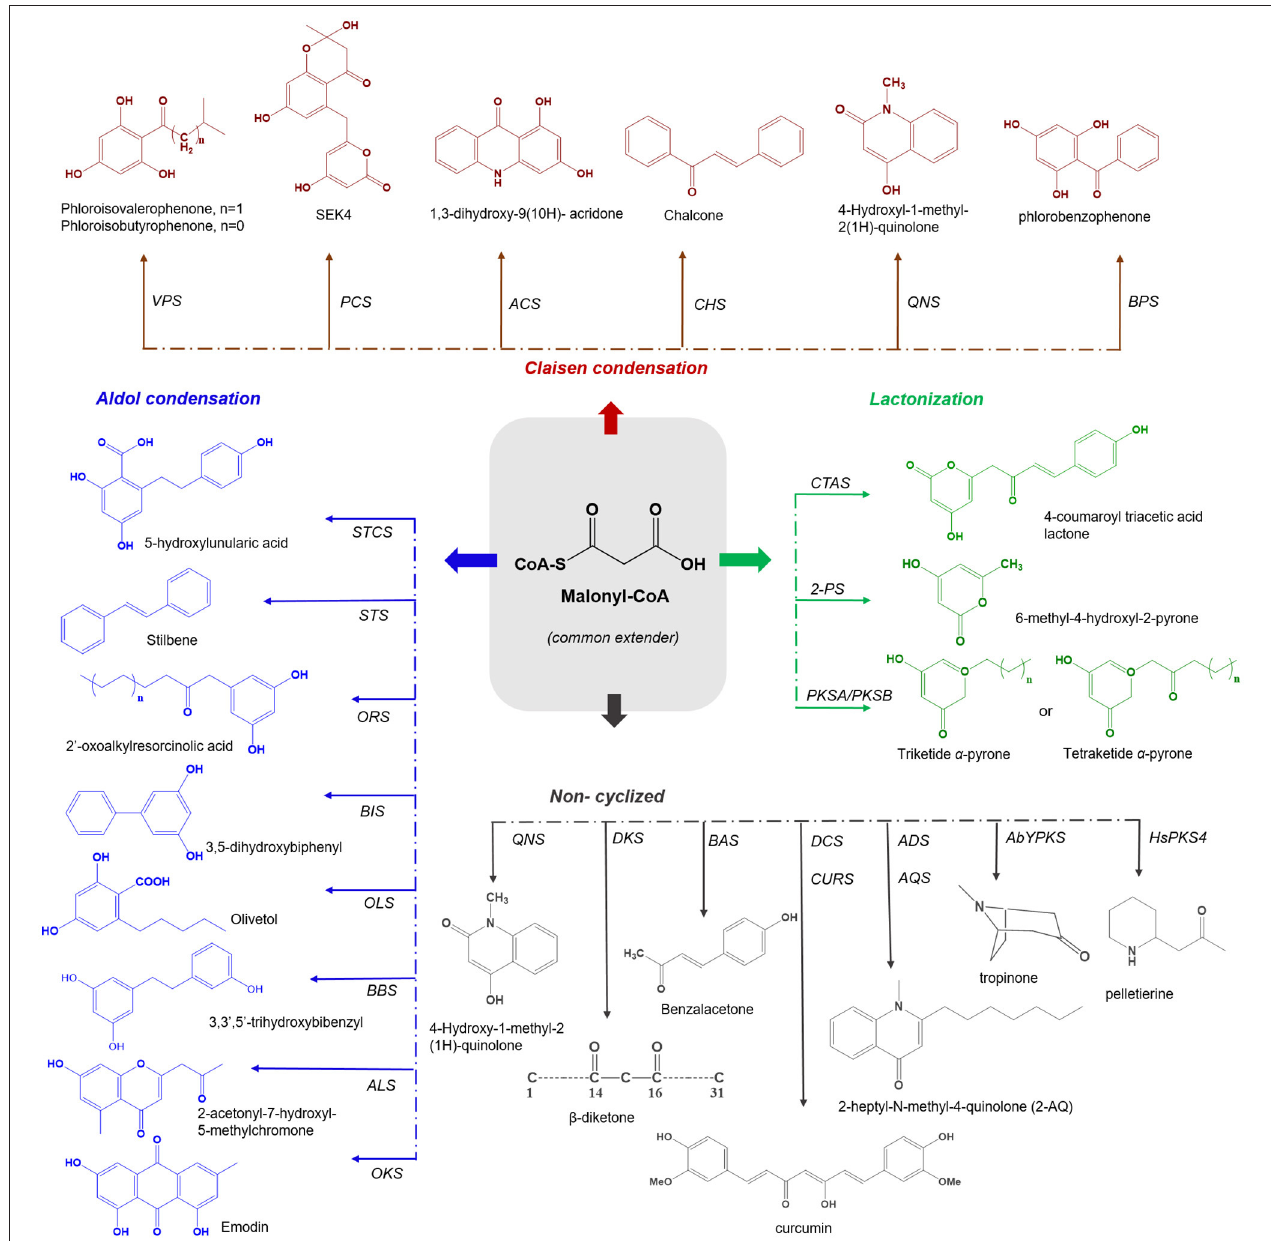
FIGURE 1 | Overview of different cyclization governed by plant type III PKSs. The common extender malonyl-CoA is utilized by several plant type III PKSs. The C6-O-C1 Claisen condensation cyclized polyketides are shown in red color (on the top), C7-O-C2 aldol condensation cyclized polyketides are depicted in blue (left), the C5-O-C1 lactonization type cyclized products are shown in green color (right) and the non-cyclized polyketides are presented in gray (bottom). VPS, valerophenone synthase; PCS, pentaketide chromone synthase; ACS, acridone synthase; CHS, chalcone synthase; QNS, quinolone synthase; BPS, benzaphenone synthase; STCS, stilbene carboxylate Synthase; STS, stilbene synthase; ORS, 2 ′ -oxoalkylresorcinol Synthase; BBS, bibenzyl synthase; OLS, Olivetol synthase; BIS, biphenyl synthase; ALS, aleosone synthase; OKS, Octaketide synthase; QNS, quinolone synthase; DKS, diketide synthase; BAS, benzalacetone synthase; DCS, diketide-CoA synthase; CURS, curcumin synthase; ADS, alkyldiketide-CoA synthase; AQS, alkylquinolone synthase; AbYPKS-type III PKS from Atropa belladonna ; HsPKS-type III PKS from Huperzia serrata ; CTAS, p-coumaroyl triacetic acid synthase; 2-PS, pyrone synthase and PKSA and PKSB, anther specific chalcone like synthase and PKSB.